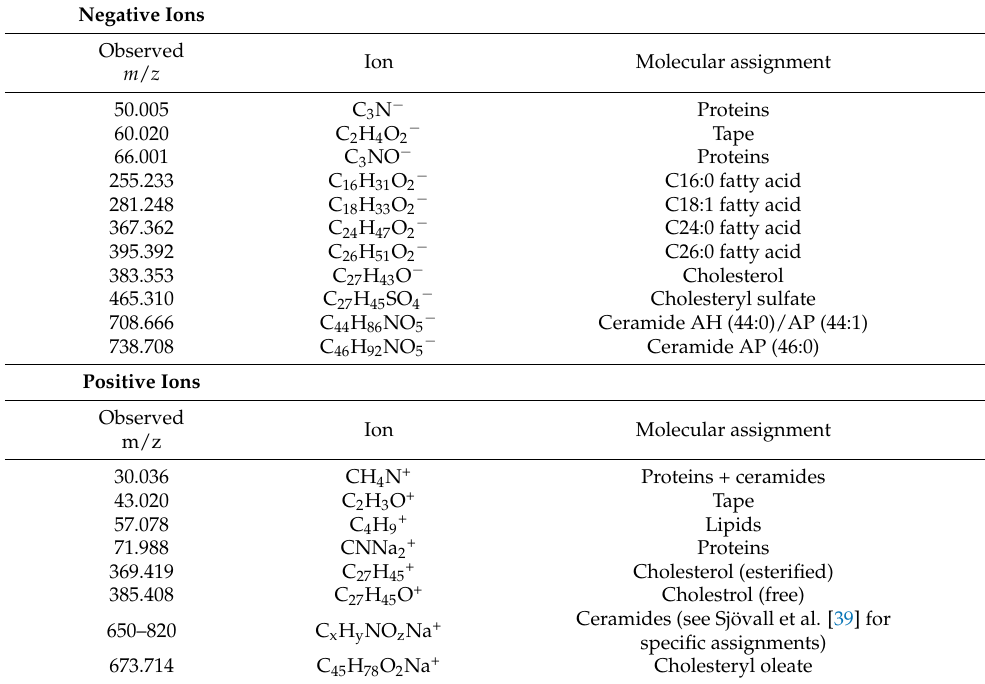
Table 1. Peaks used to monitor different molecular components in SC during 3D ToF-SIMS